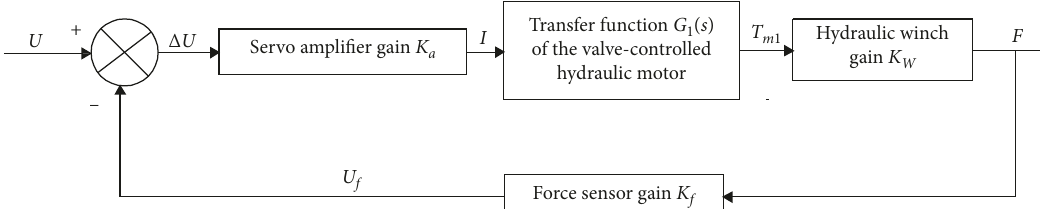
Figure 4: The control process block diagram of the feed-forward compensation corrected system.